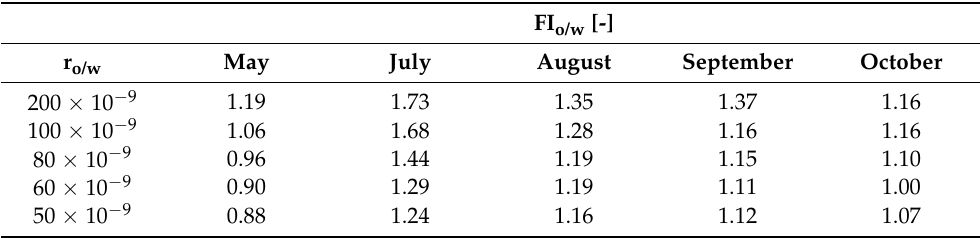
Table 4. FI o/w for seawater polluted by a mixture of oils for various oil-to-water-ratios r o/w for May,